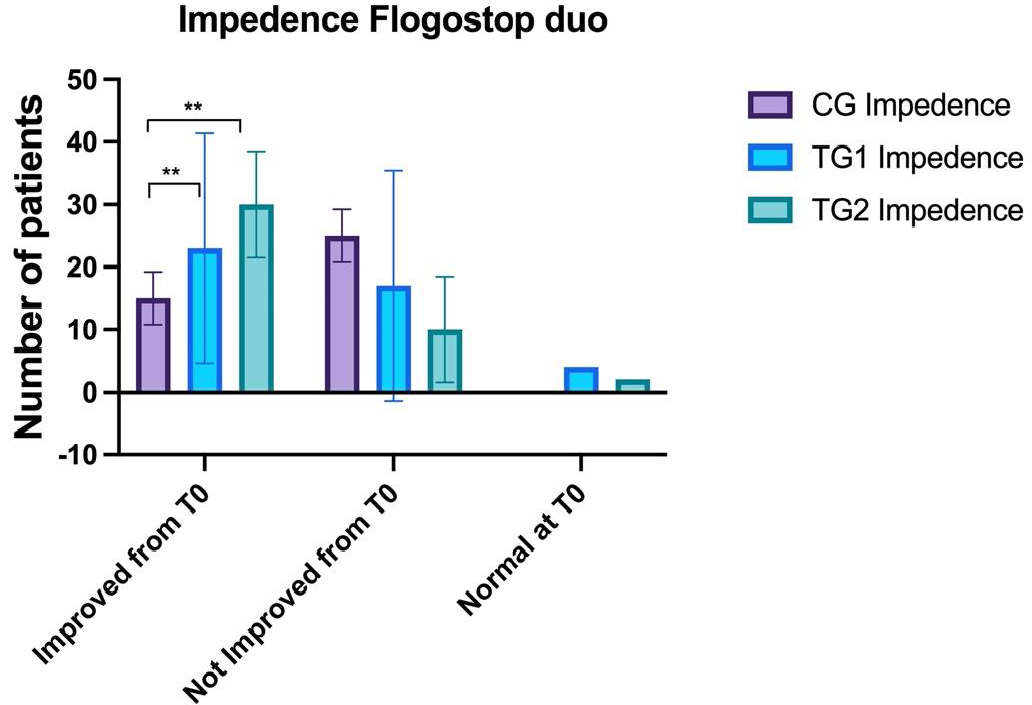
Figure 3. Comparison of the impedance findings between the three groups. Control Groups (CG), Treatment Group 1 (TG1), and Treatment Group 2 (TG2) . Standard deviation “I”. The asterisk “**” Treatment Group 1 (TG1), and Treatment Group 2 (TG2). Standard deviation “I”. The asterisk indicates p < 0.01. “**” indicates p <